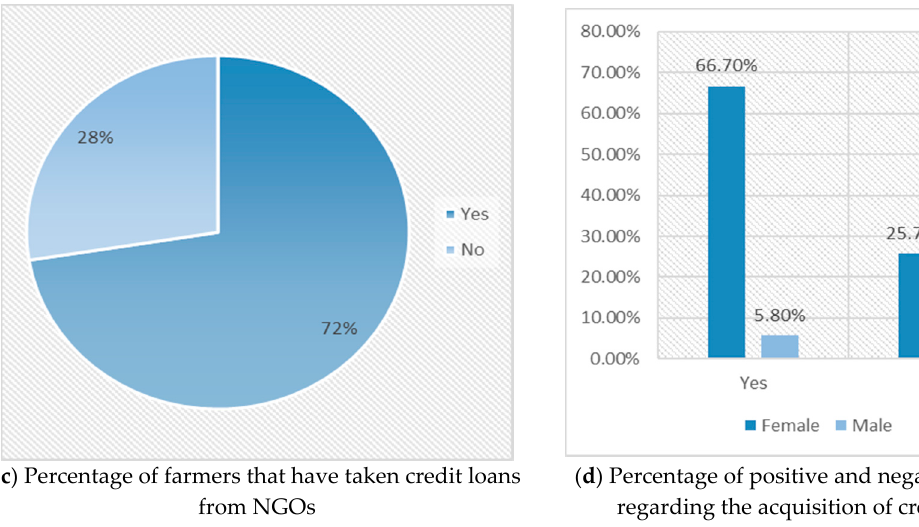
Figure 2. Implementation of adaptation strategies by farmers, acquisition of loans to implement adaptation strategies, and attitudes regarding loan acquisition. ( a ) Percentage of farmers that reported implementation of adaptation strategies; ( b ) Implementation of adaptation strategies by gender; ( c ) Percentage of farmers that have taken credit loans from NGOs to implement adaptation strategies; ( d ) Percentage of positive and negative attitudes regarding the acquisition of credit loans to implement adaptation strategies by gender.